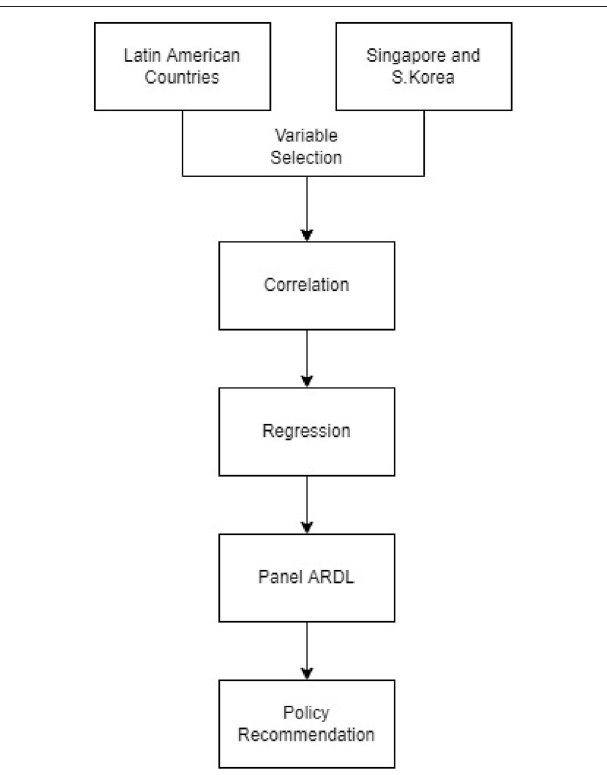
FIGURE 2 | Flowchart of the proposed study.